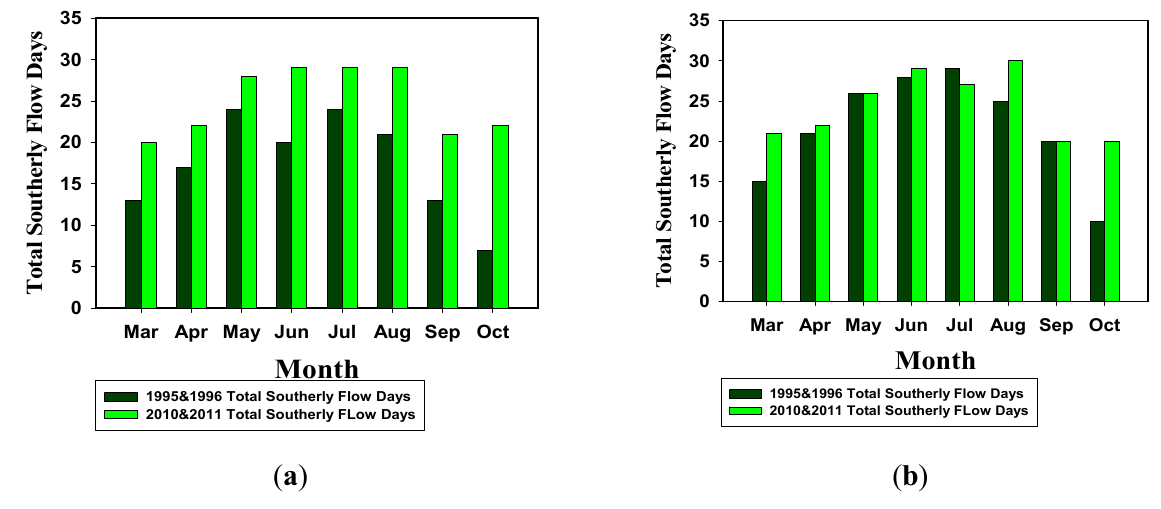
Figure 6. Days with southerly flow at Aldine ( a ) and Galveston ( b ) average over 1995–1996 (dark green) and 2010–2011 (light